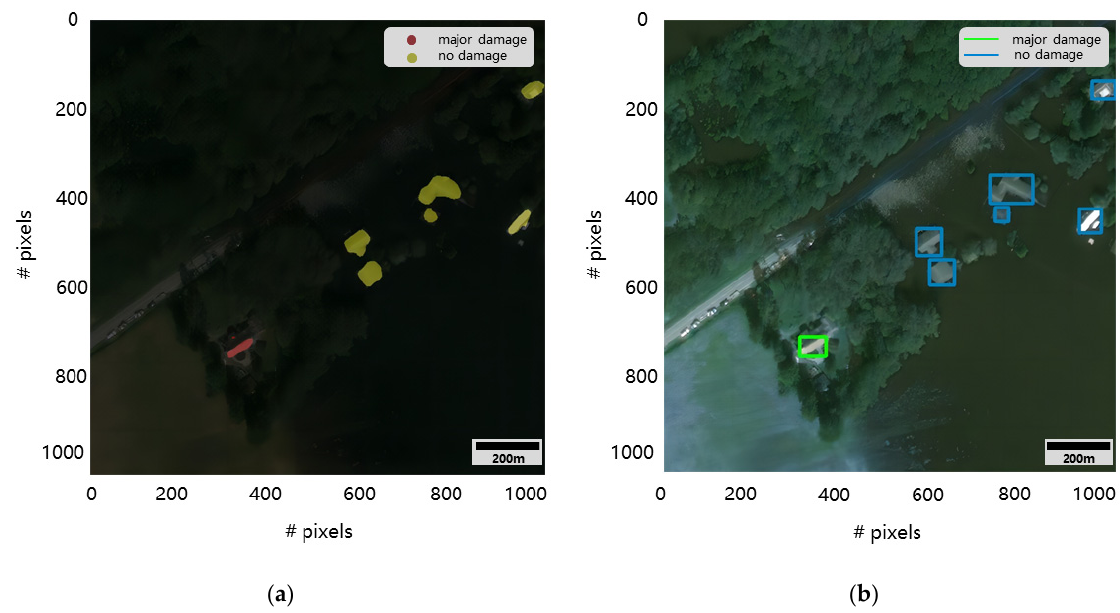
Figure 6. SegDetector’s horizontal detection implementation. ( a ) is the pixel-by-pixel result calculated by SegDetector and ( b ) is the horizontal detection result calculated by SegDetector. Rotating target detection is now a popular research direction in target detection. It can delineate a more accurate target range compared to horizontal target detection, and is usually implemented by adding the prediction of rotation angle to the conventional target prediction of x, y, w, h. This, however, further deepens the difficulty of model implementation. The SegDetector model proposed in this study can be modified by the way the target frame is delineated, and the rotating target detection function can be implemented quickly and easily. After obtaining the semantic segmentation output, the image is binarized and the smallest outer rectangle is found based on each channel, as shown in Figure 7. Compared to horizontal target detection, it can be observed by comparing the two images in Figures 6 and 7 that rotating target detection can be more accurate in delineating the target position. The complexity of the rotating target detection implementation is com- parable to that of the horizontal target detection implementation.